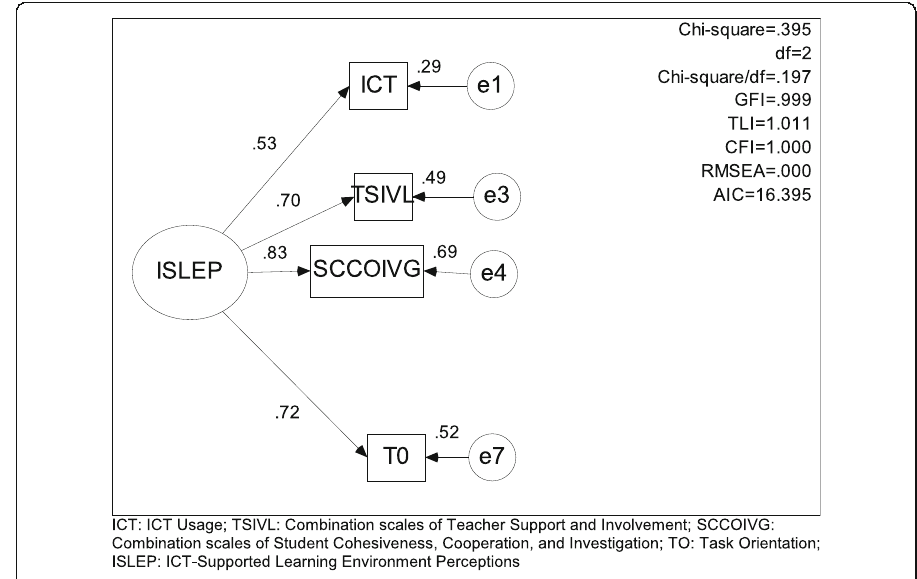
Fig. 6 The second-order measurement model of ICT-supported learning environment perceptions derived from item